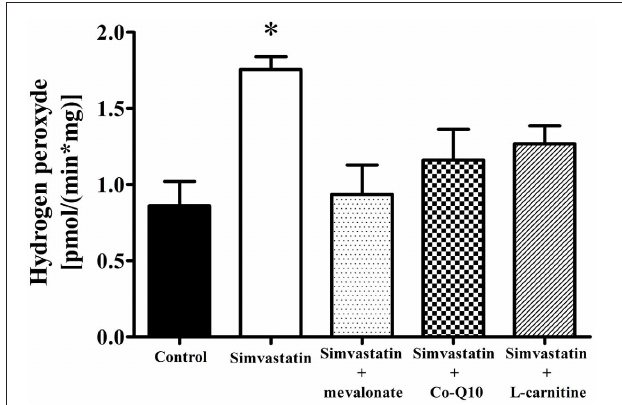
FIGURE 6 | Increase in hydrogen peroxide release by 1 µ M simvastatin was prevented by mevalonate, Co-Q10 or L-carnitine in skeletal muscle. Permeabilized skeletal muscle samples were incubated, for 1h, in medium MiR05 containing 1 μ M simvastatin or DMSO, 10 μ M Amplex red, 1 U/mL horseradish peroxidase, 10mM glutamate, 5mM malate, or simultaneous incubated with 100 μ M mevalonate, 10 μ M coenzyme Q10